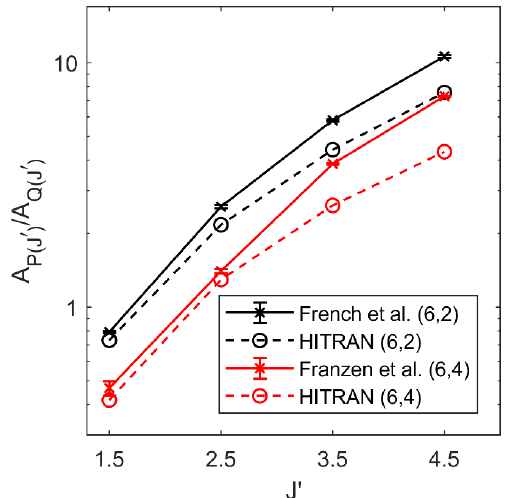
Figure 4. In black: The ratio of the Einstein coefficients derived from the P-and Q-branch lines French et al. [15] of the (6,2) transition (crosses) and the HITRAN values for the (6,2) transition (circles, dashed). In red: The same ratio from this study of the (6,4) transition using the spectral fit method (crosses) and from HITRAN for the same transition (circles, dashed).